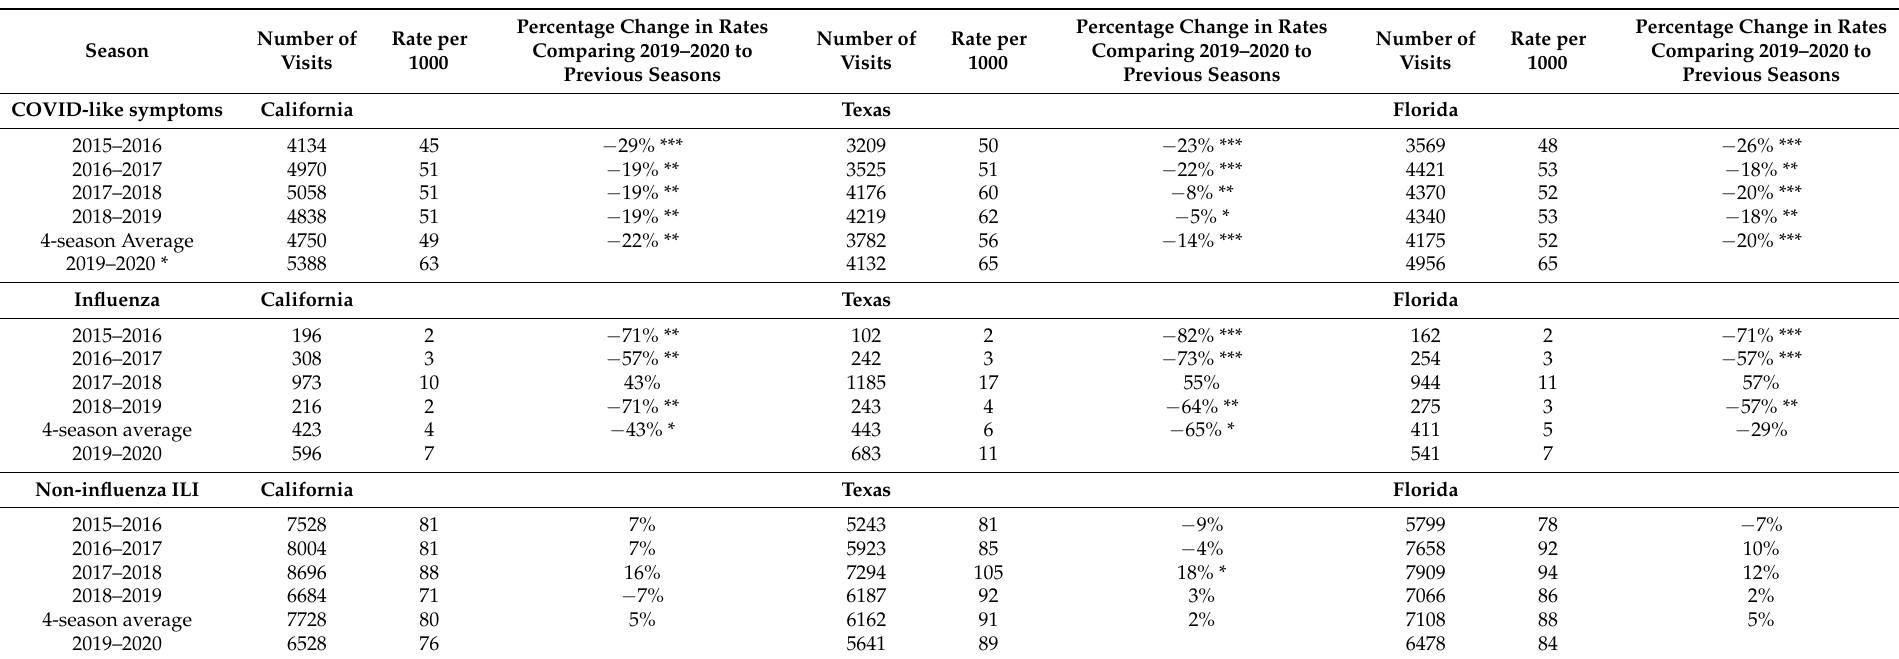
Table 1. Number of ED visits, rate per 1000 ED encounters during first 23 weeks of five flu seasons (1 October–29 February), and difference in rates between each